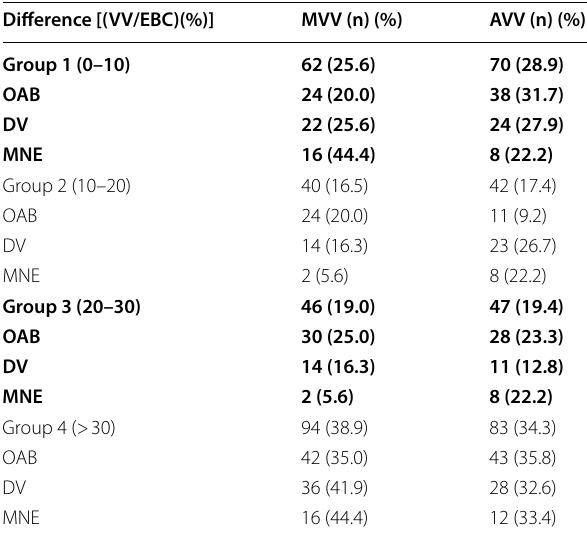
Table 3 Stratification of patients according to VV threshold difference between VD and UF